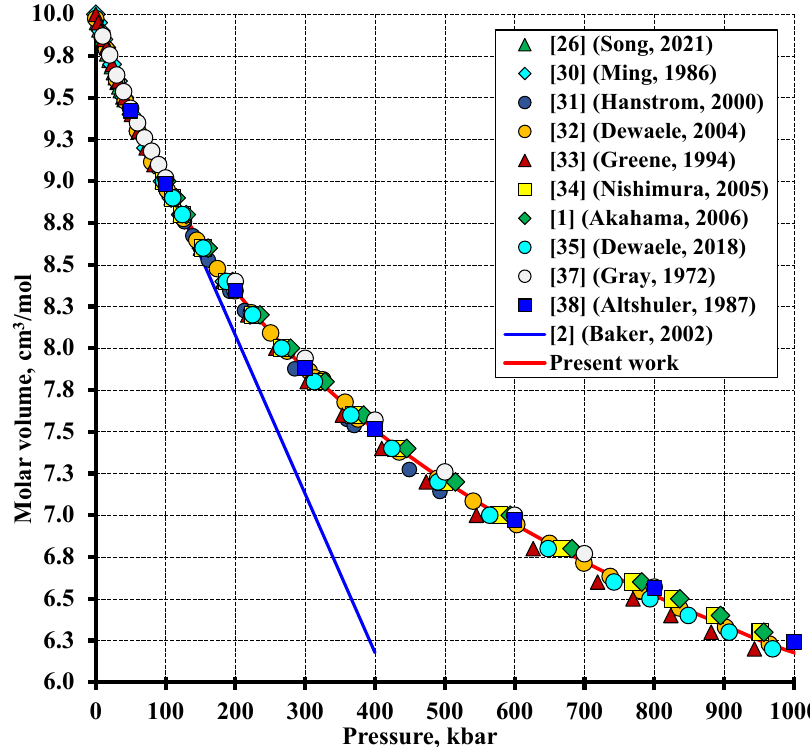
Figure 3. Volume compression of aluminum at 25 °C.